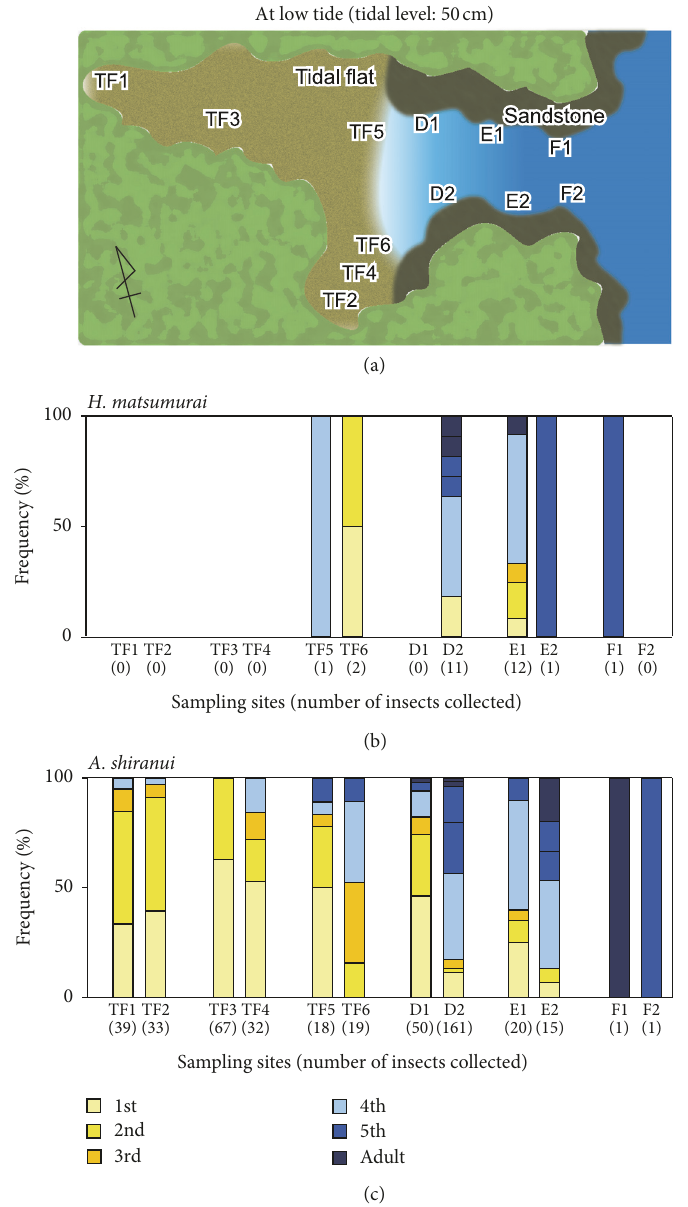
Figure 4: (a) Sampling sites (TF1, TF2, TF3, TF4, TF5, TF6, D1, D2, E1, E2, F1, and F2) at low tide. (b) Composition of developmental stages of H. matsumurai and (c) of A. shiranui at each sampling